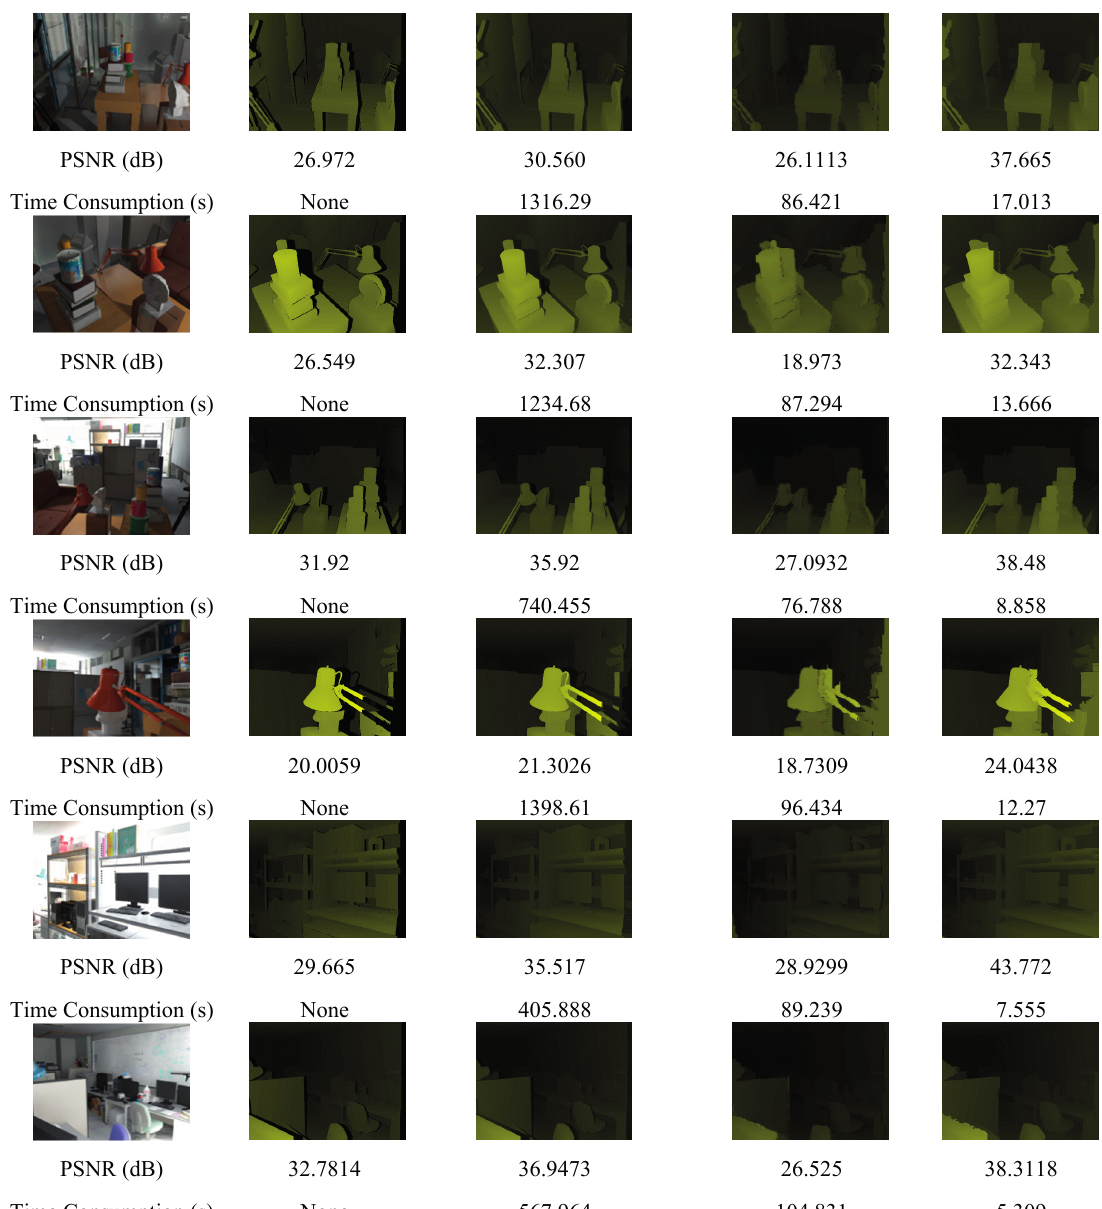
Figure 4. Ten different images from the Tsukuba Stereo